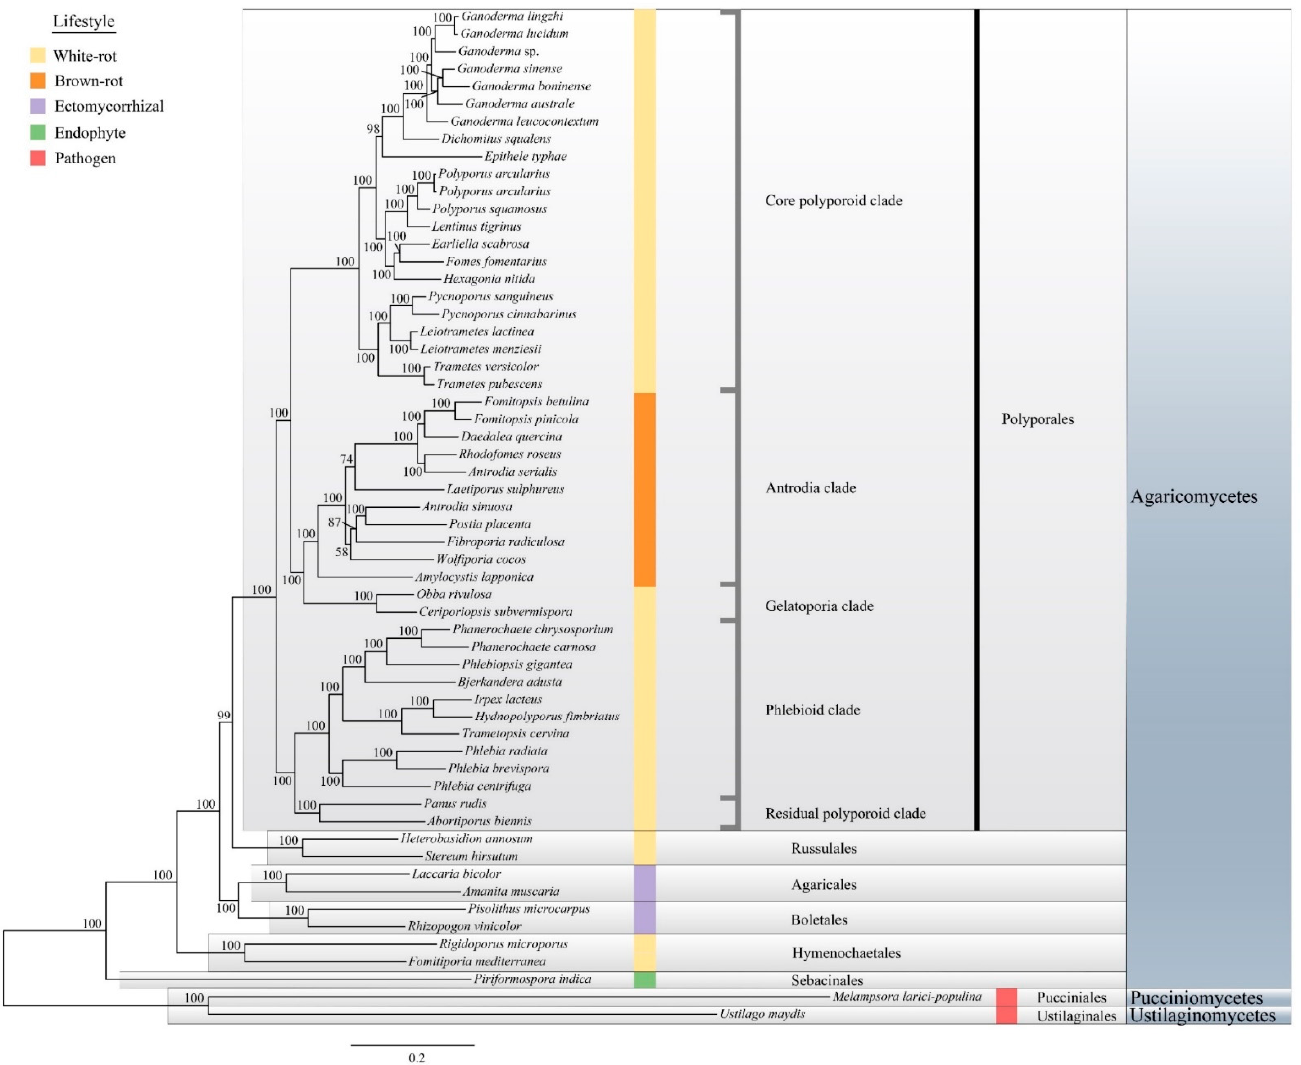
Figure 3. Phylogenetic relationship within the Ganoderma clade and 58 selected Basidiomycota species. The ‘best tree’ resulting from maximum likelihood (ML) analyses based on 143 single-copy genes and ML bootstrap values are shown. Colors are coded for the five lifestyles.